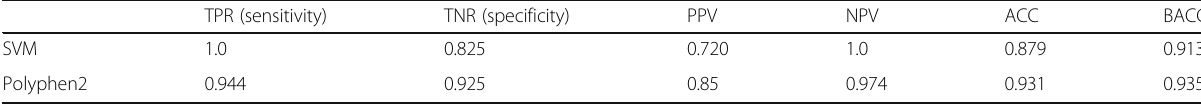
Table 4 Measurements of benchmarking